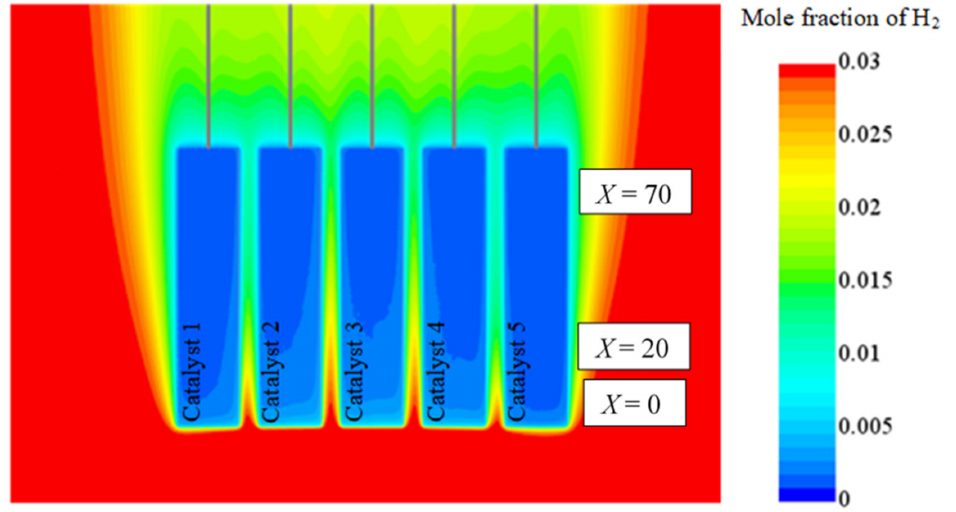
Figure 11. H 2 distribution map of Pt/AAO catalyst obtained at steady-state conditions, determined by CFD simulation.